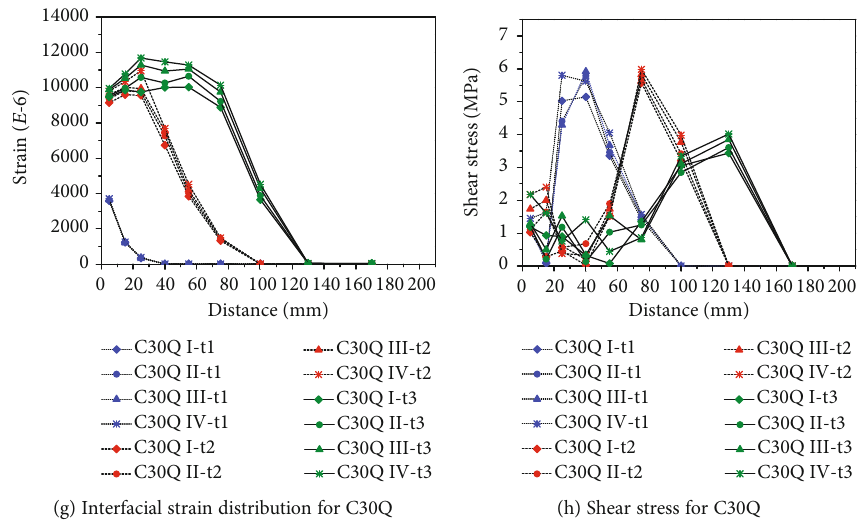
Figure 5: Interfacial strain distribution and shear stress for di ff erent